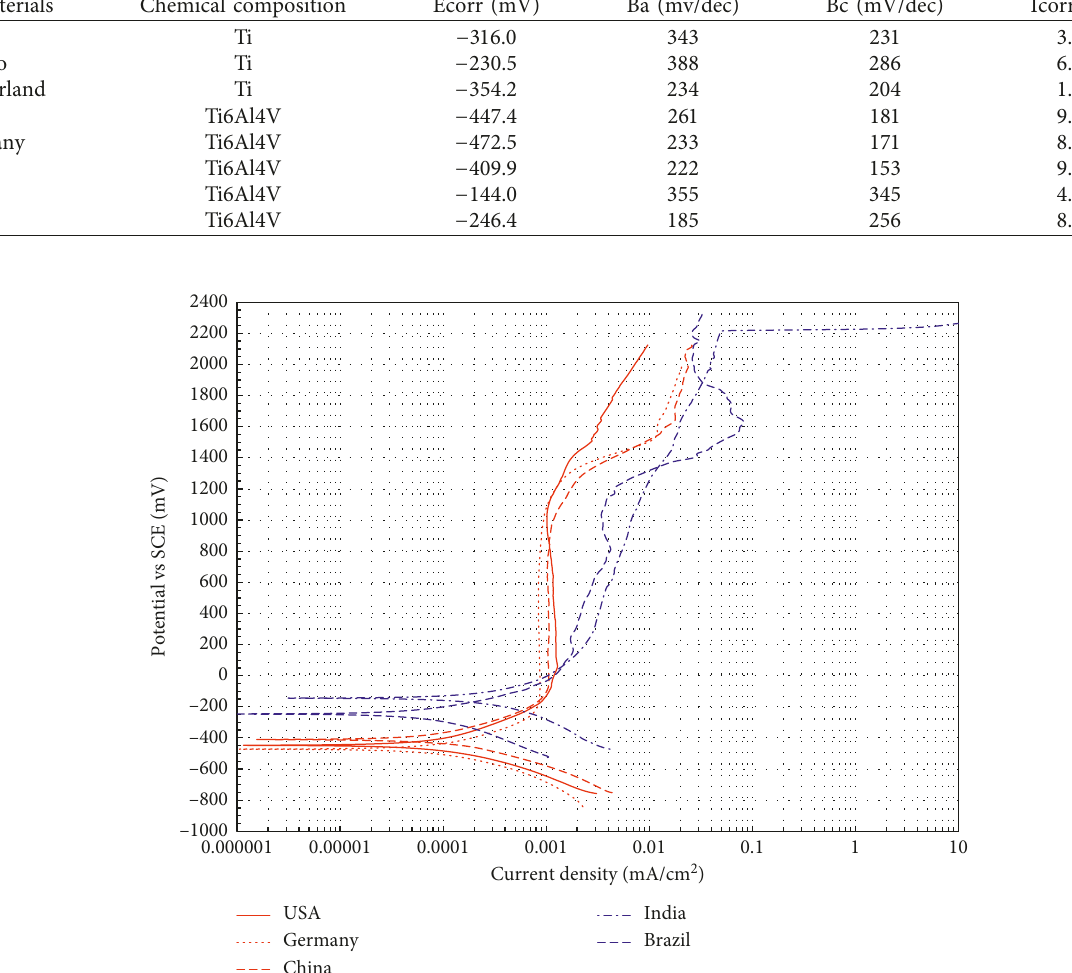
Figure 2: Potentiodynamic polarization curves for Ti6Al4V biomaterials in 0.9% NaCl solution at 37 ° C (0.1667mVs − 1